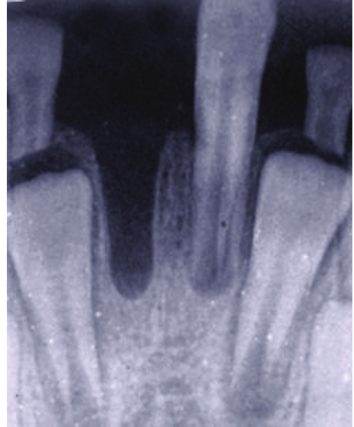
Figure 1: Preoperative radiograph showing the intact socket of right lower central incisor.